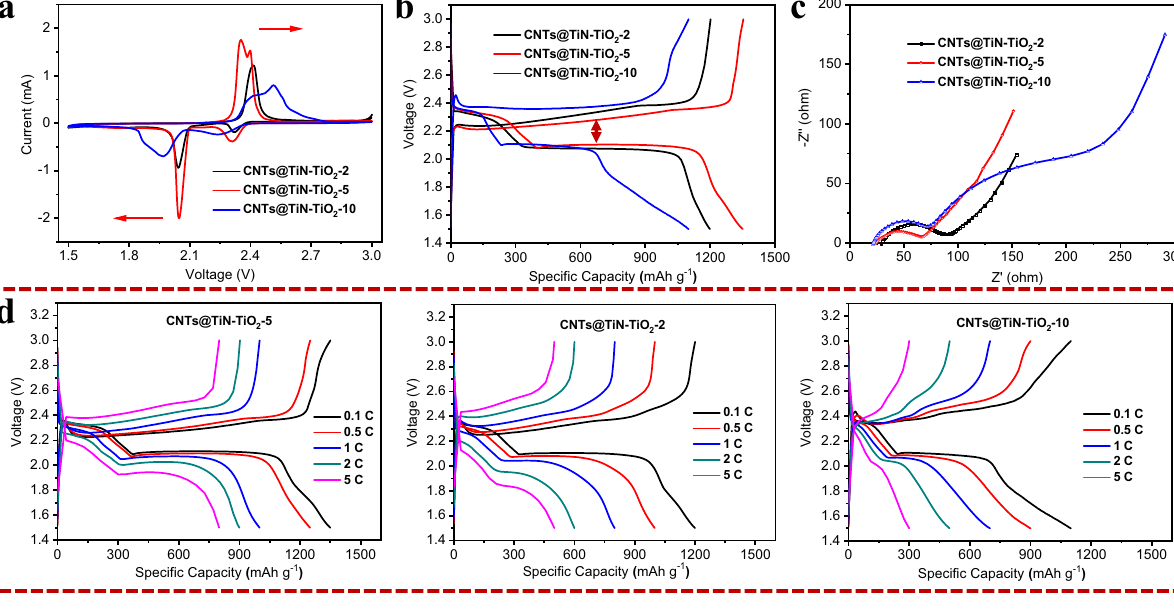
Fig. 5 Electrochemical performance of CNTs@TiN – TiO 2 -2, CNTs@TiN – TiO 2 -5, and CNTs@TiN – TiO 2 -10. a CV curves at the scan rate of 0.1 mV s − 1 , b galvanostatic charge and discharge curves, c EIS curves, and d rate performance from 0.1 to 5 C of CNTs@TiN – TiO 2 -5, CNTs@TiN – TiO 2 -2, and CNTs@TiN – TiO 2 -10. Source data are provided as a Source Data fi